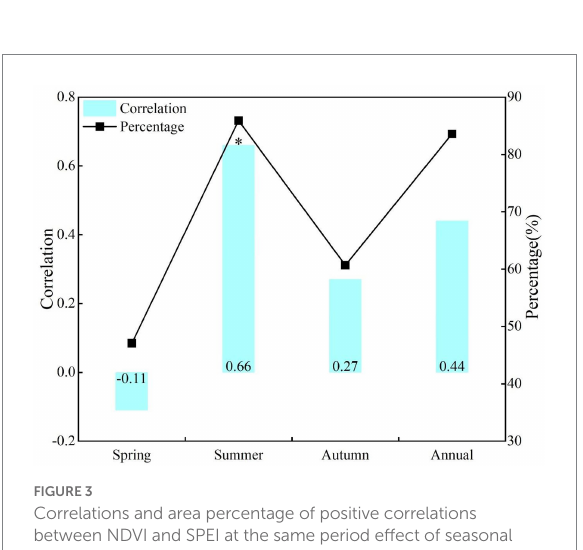
FIGURE 3 Correlations and area percentage of positive correlations between NDVI and SPEI at the same period effect of seasonal and annual scales.